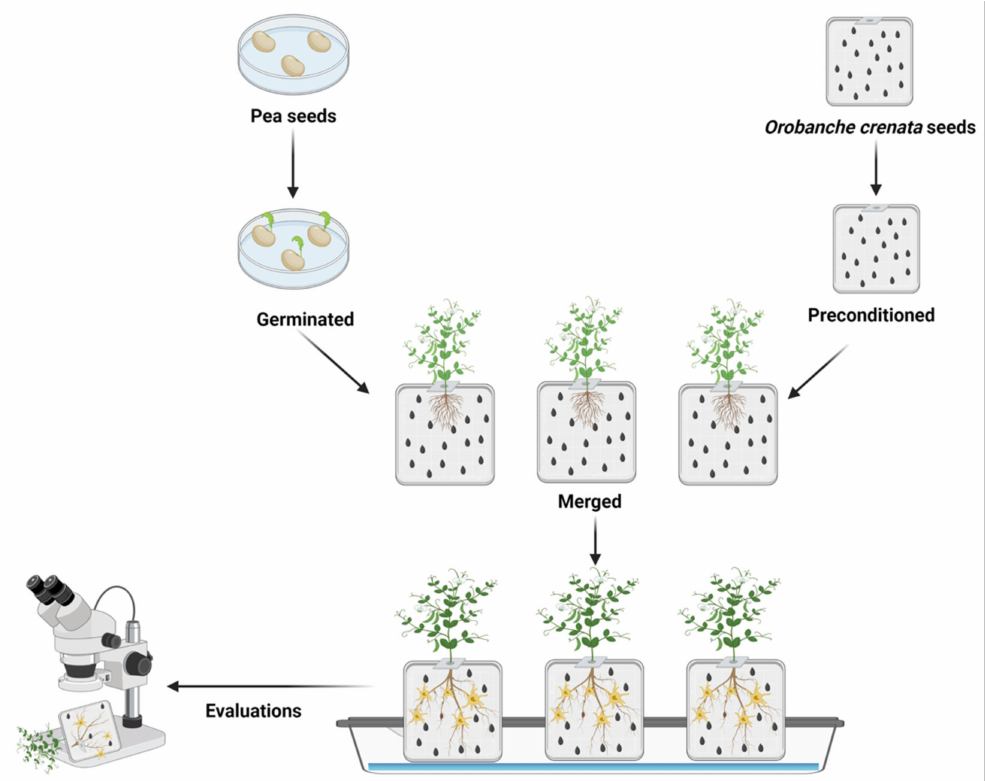
Figure 5. A mini-rhizotron set up for O. crenata screening, indicating pre-germination of host plant seeds and preconditioning of parasitic seeds to merger for association and evaluation. (Illustration made in